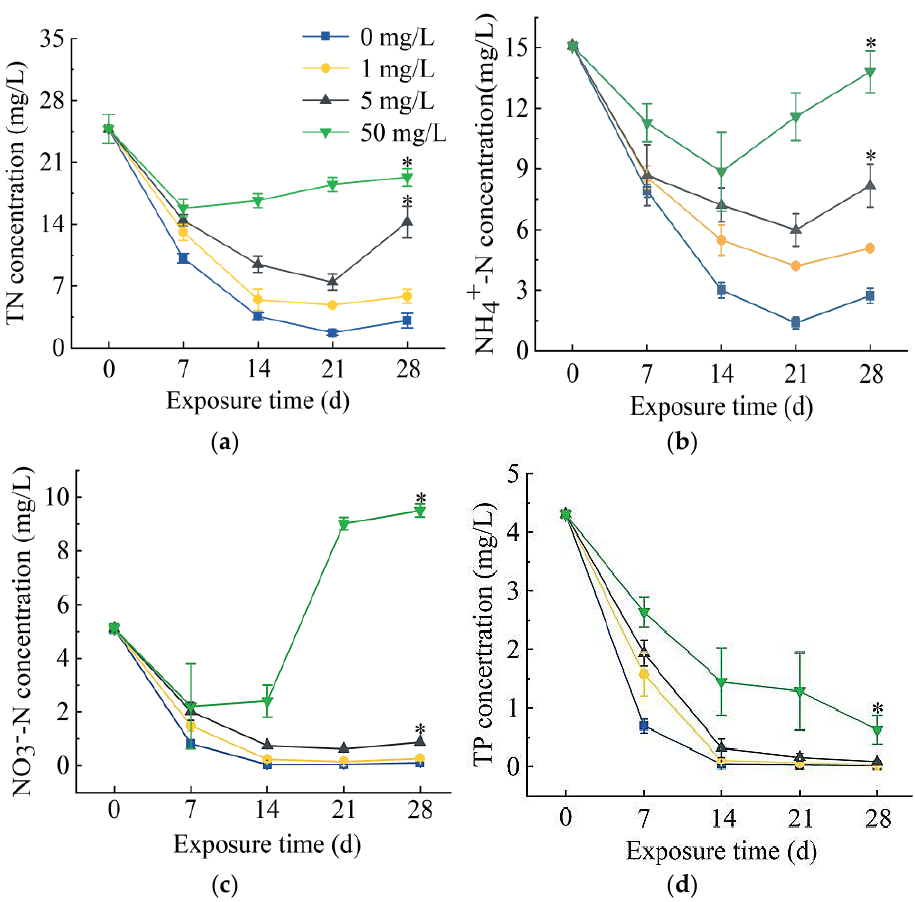
Figure 1. The changes in concentrations of total N (TN) ( a ), NH 4+ -N ( b ), NO 3– -N ( c ), and total phosphorus (TP) ( d ) in wastewater treated with 0, 1, 5, or 50 mg/L SD over the course of S. portulacastrum plant growth for 28 days. Data are means ± standard deviation ( n = 3). The asterisk (*) indicates significant differences based on Duncan’s Multiple Range test at p < 0.05 level.